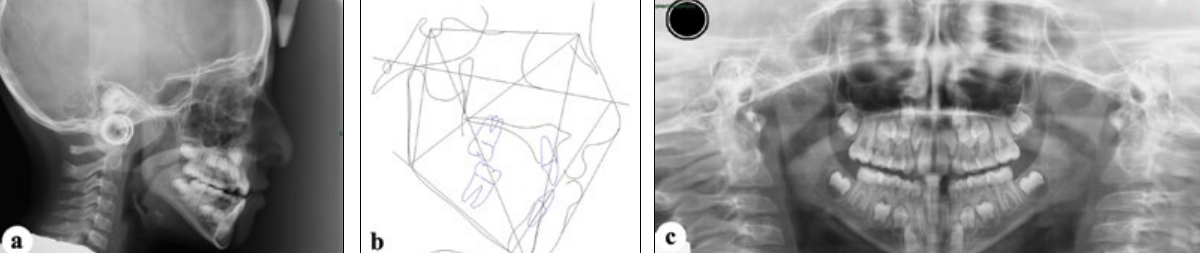
Figure 2. Pretreatment radiographic images. (a) Lateral cephalogram. (b)Tracing. (c)Panoramic